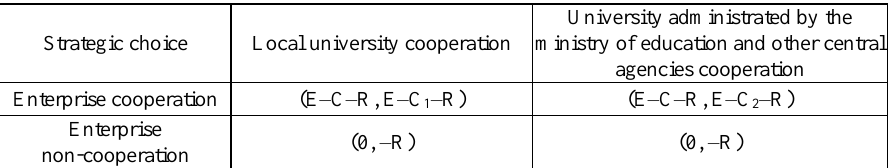
Table 2. Game profit matrix between enterprises and local universities and universities administrated by the ministry of education and other central